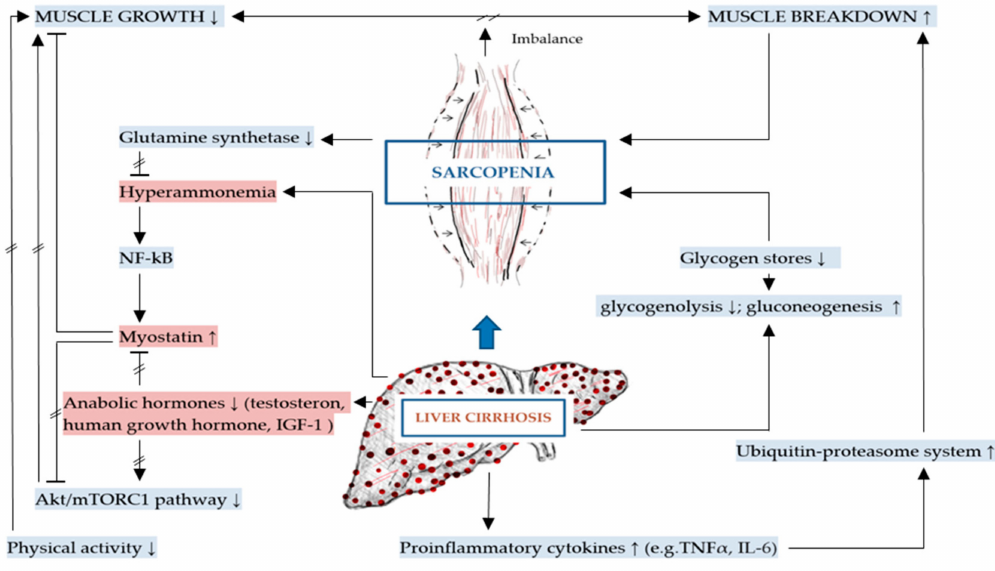
Figure 2. Mechanisms specific to sarcopenia in liver cirrhosis (key mechanisms contributing to sarcopenia in liver cirrhosis are highlighted in